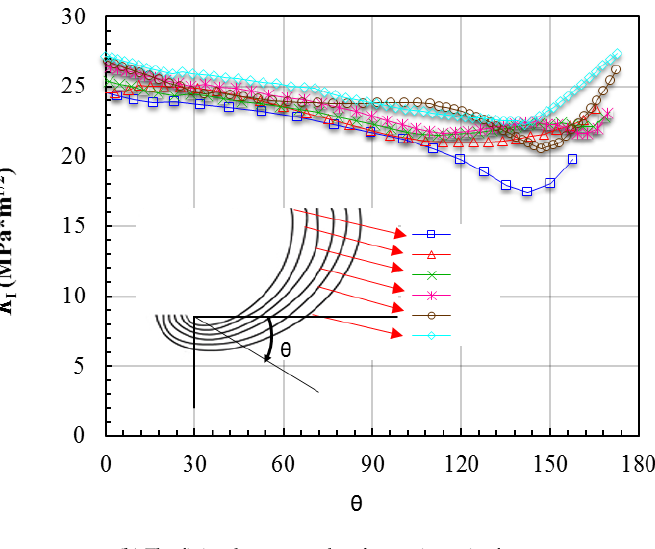
Figure 19. Modified stress intensity factor prediction by empirical formula in the beginning part of trace lines of the third stage. (The different color lines represent different crack front.) Table 8. Stress intensity factor comparison between empirical formula and finite element analysis